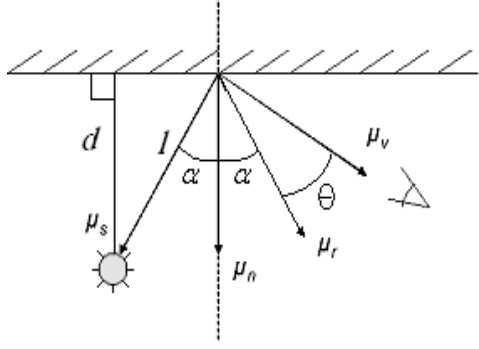
Figure 2. Diagram for Phong’s illµmination model .